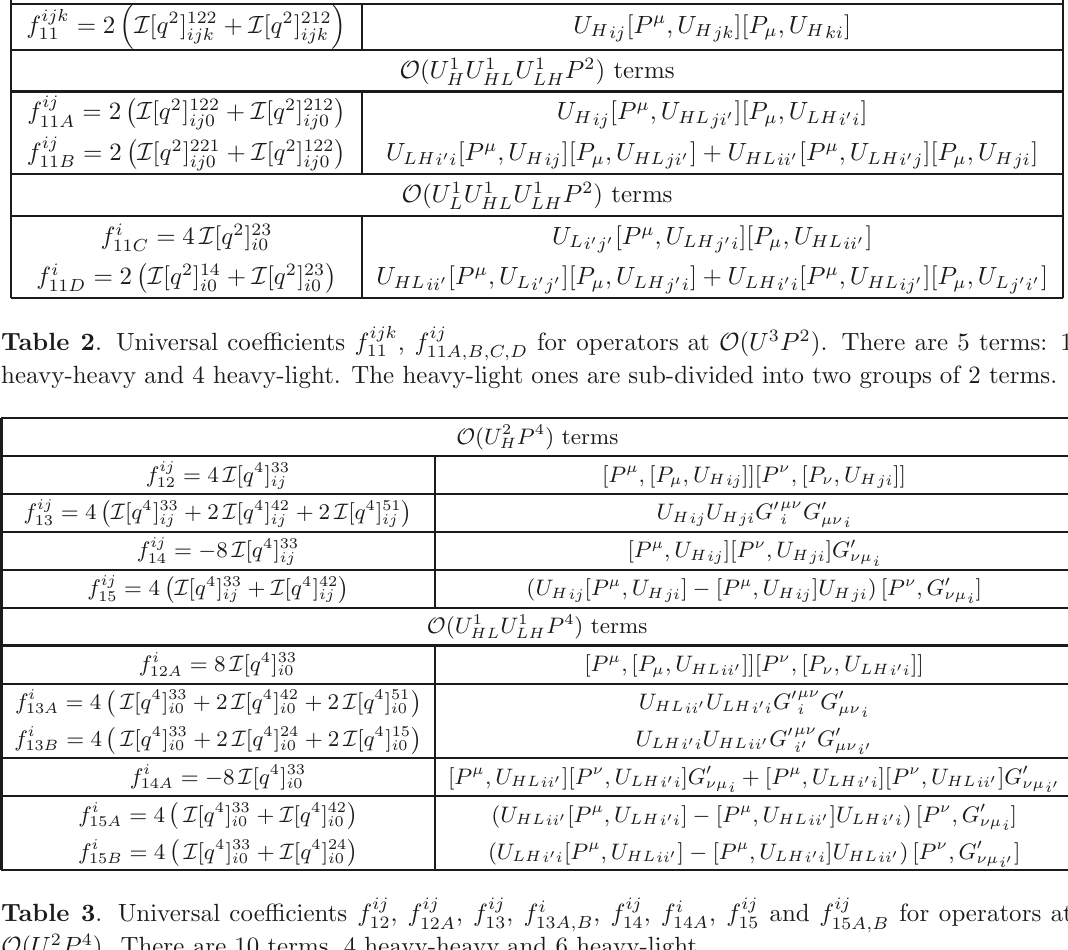
, f ij , f ij , f i , f ij , f i , f ij and f ij for operators 12 13 14 15 13 A,B 14 A 12 A 15 A,B